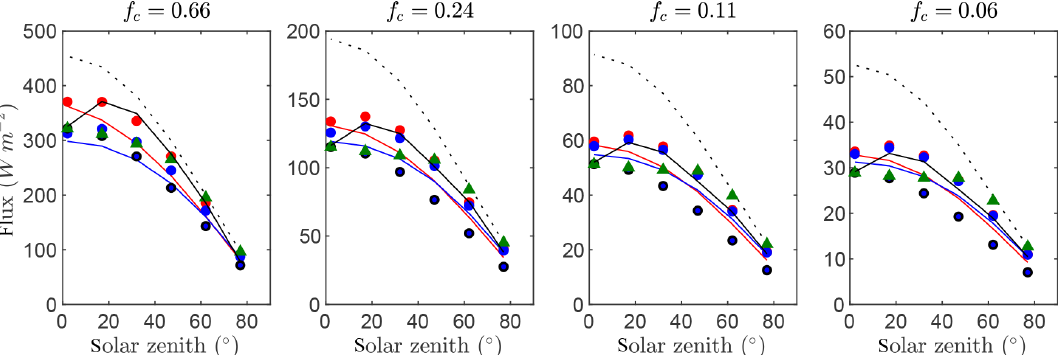
Figure 9. Flux of intercepted radiation versus solar zenith angle for a half-diurnal cycle in a canopy non-tree plants (potato; see Fig. 3f). Varying ground cover fractions f c were simulated as labeled in each pane. The exact flux is given by the output of the 3-D model (black line), which is compared against the 1-D models BINOM (red line), NIL99_B (red circle), and NIL99_P (blue circle) and Ni10_P (blue line), OM_CON (black circle), OM_VAR (green triangle), and HOM (dotted